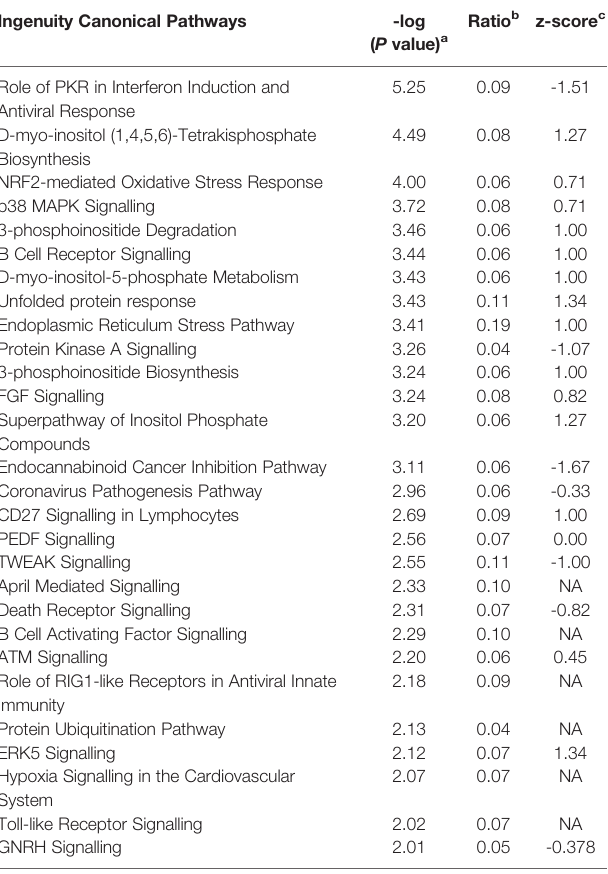
TABLE 3 | IPA canonical pathways in PBMC at the acute stage of F. hepatica infection in sheep as identi fi ed by the infected vs control analysis, with a signi fi cance cut-off of P =0.01 ( – log( P -value) of 2). Ingenuity Canonical